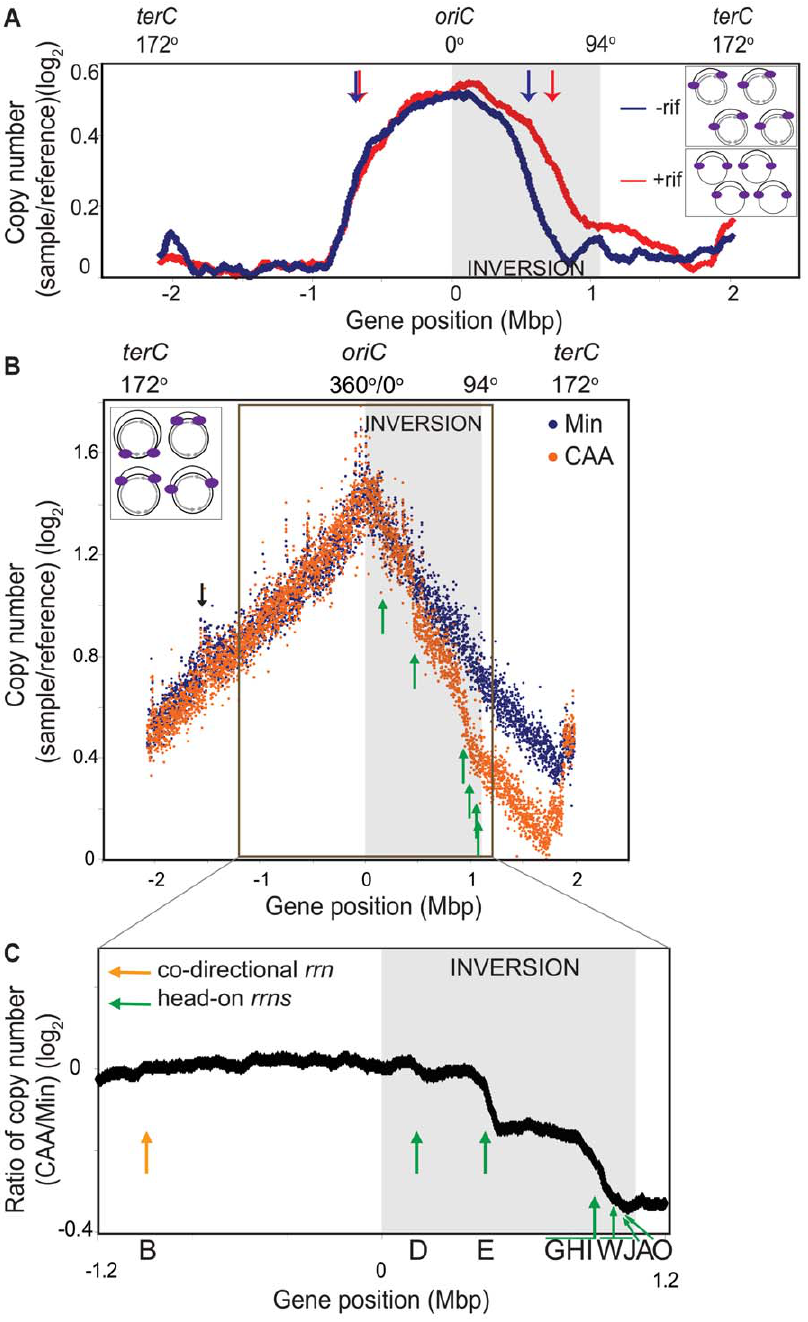
Figure 2. Genomic microarray profiles of the HT inversion strain. (A) Synchronized replication profile of the HT strain. Cells containing the dnaB134 ts allele were grown in Min at 30 u C and their replication cycle was synchronized by shifting to 45 u C for 60 minutes, and then back to 30 u C to allow replication initiation. Genomic profiles were obtained 30 minutes after initiation, relative to pre-initiation reference DNA. Profiles were obtained without (blue) or with (red) addition of rifampicin (rif) 4 minutes after initiation to inhibit transcription. Elevation of the baseline of the gene dosage profile on the right replichore is likely due to incomplete replication of the pre-initiation reference DNA of the HT strain, despite the 60 minutes incubation at 45 u C. Grey shaded region: inversion; blue and red arrows: average positions of replication forks in the absence (blue) or presence (red) of rif. Insets: schematic diagram of chromosomes of the HT strain undergoing synchronized replication with (top), and without (bottom) transcription (grey arrows). Purple ovals: replisomes. (B) Overlay of the asynchronous genomic profiles of the HT strain grown in Min (blue), and CAA (orange). Profiles were obtained from asynchronous cultures grown at 37 u C to OD 600 , 0.5. Average gene dosage ratios (log 2 ) are plotted relative to gene positions adjusted according to deletion of the phage SP b and the integrative and conjugative element ICE Bs 1 clusters. The prophage-like skin element is not removed in this strain, which likely explains the small peak at 2 1.5 Mbp (black arrow). Green arrows: sharp changes in slope at rRNA loci in the CAA profile. Inset: schematic diagram of chromosomes of the HT strain undergoing asynchronous replication. (C) Expanded view of the ratio of gene dosage (log 2 ) in CAA versus Min within the region outlined in B ( 2 1.2 Mbp to 1.2 Mbp). Green arrows: positions of inverted rRNA operons; orange arrow: position of co-directional rrnB ; grey shaded region: inversion.